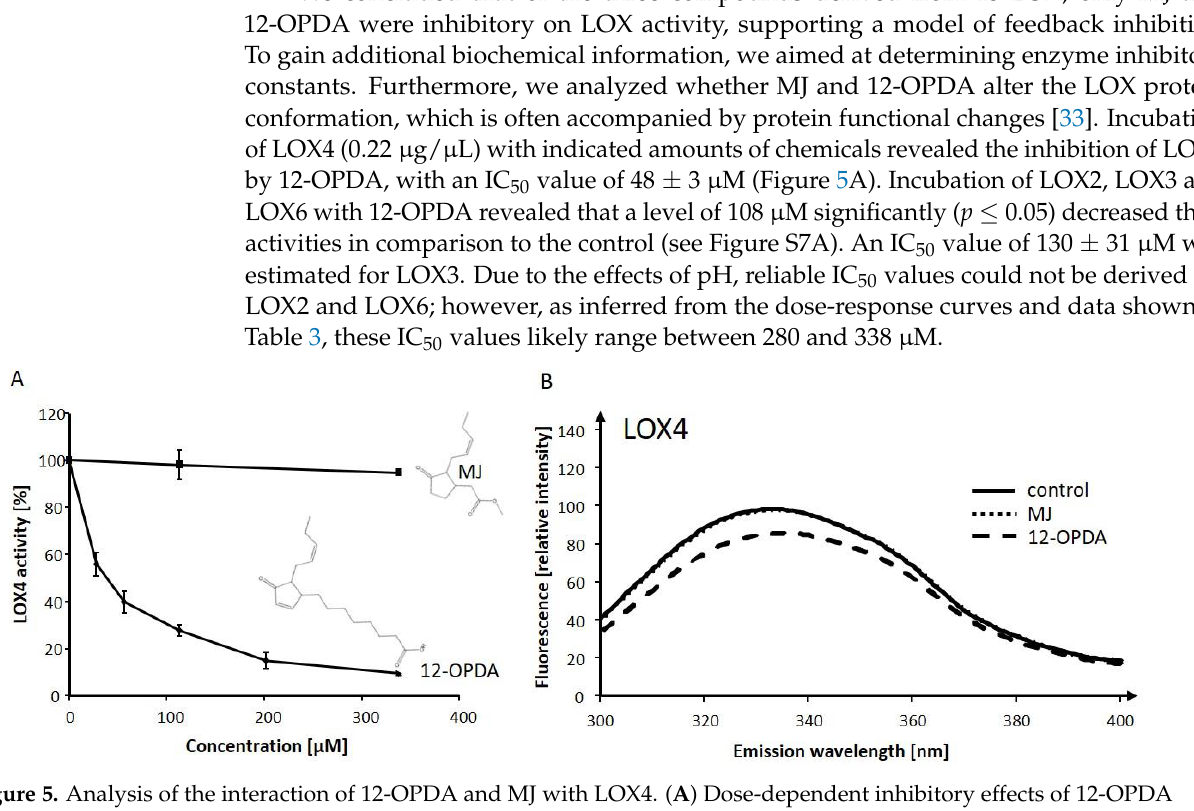
Figure 5. Analysis of the interaction of 12-OPDA and MJ with LOX4. ( A ) Dose-dependent inhibitory effects of 12-OPDA and MJ on the activity of LOX4. LOX4 (0.22 µg/µL) was incubated with compounds at indicated concentrations for 10 min at 30 °C, and residual LOX activity was measured spectrophotometrically by the injection of 3 µL incubation mixture into 123 µL LeA (4.8 µM in 50 mM Tris-HCl, pH 7.2). Values (nmol . s −1. mg −1 , means ± SD (n = 3)) are given relative to LOX4 activity (38.0 ± 2.0) obtained with solvent (control). ( B ) Intrinsic fluorescence of LOX4 incubated with 12-OPDA, MJ and solvent (control). Here, 120 µL LOX4 (0.2 µg/µL) was mixed with 15 µL chemical (1.4 mM in 50 mM K-Pi, pH 8.0) or solvent (control) and analyzed for intrinsic fluorescence emission after excitation at λ Exc = 280 nm. Mean graphs are shown (n = 4).